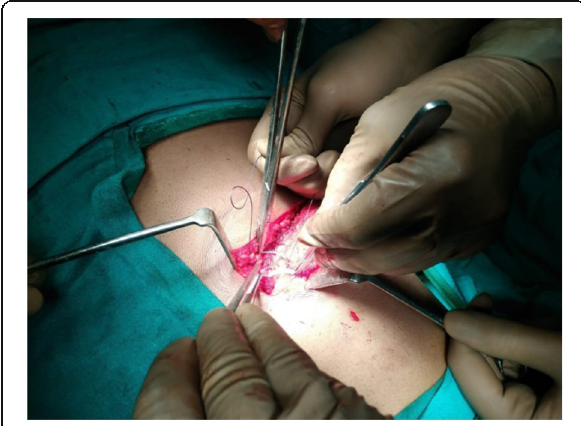
Fig. 2 Image showing clamped right sided VP shunt (indicated by the arrow). The procedure was on right side, the shunt was found adhered omentum but intact. It was clamped during surgery later peritoneal end of shunt was released in abdomen